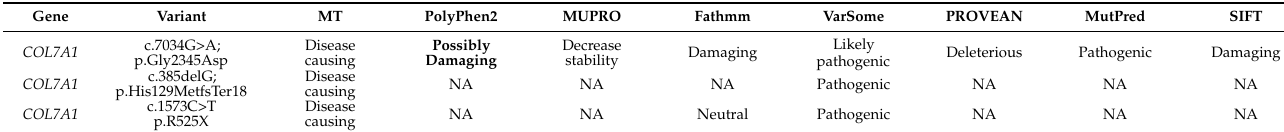
Table 2. Pathogenicity detection of COL7A1 variants.